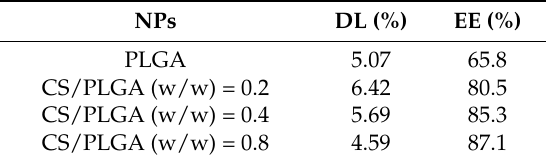
Table 3. Drug Loading Efficiency and Encapsulation Efficiency of